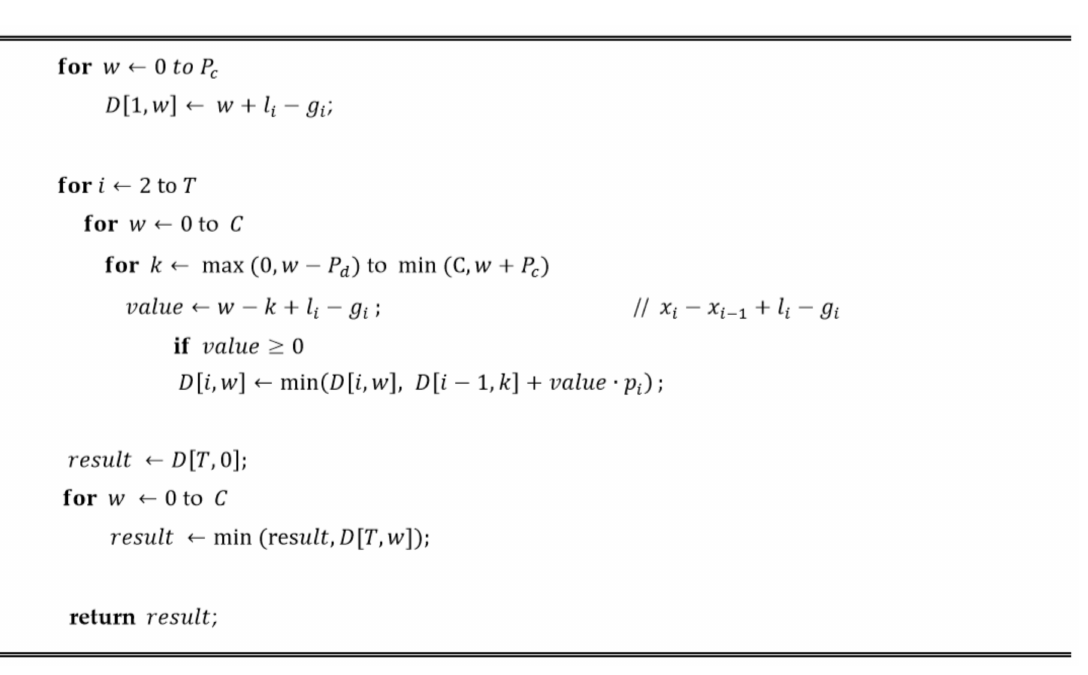
Figure 1. Pseudocode of the proposed dynamic